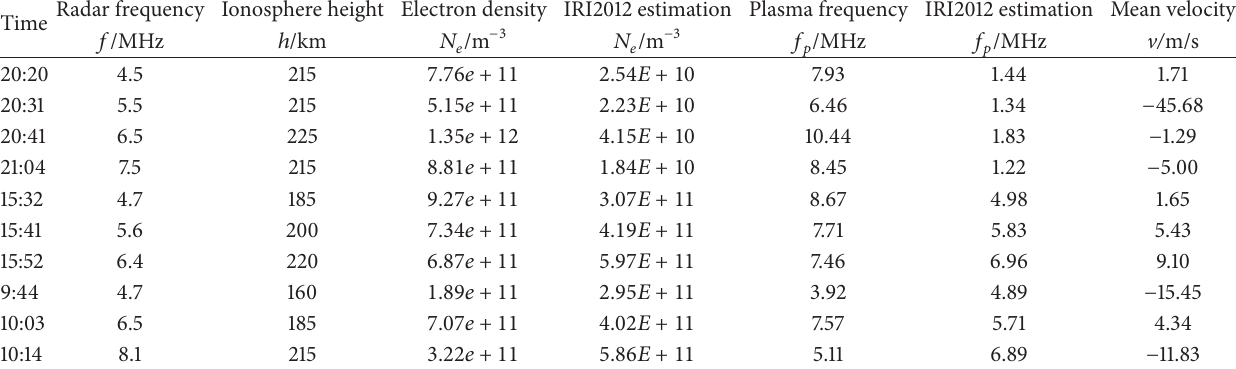
Table 1: Experimental results compared with IRI2012.